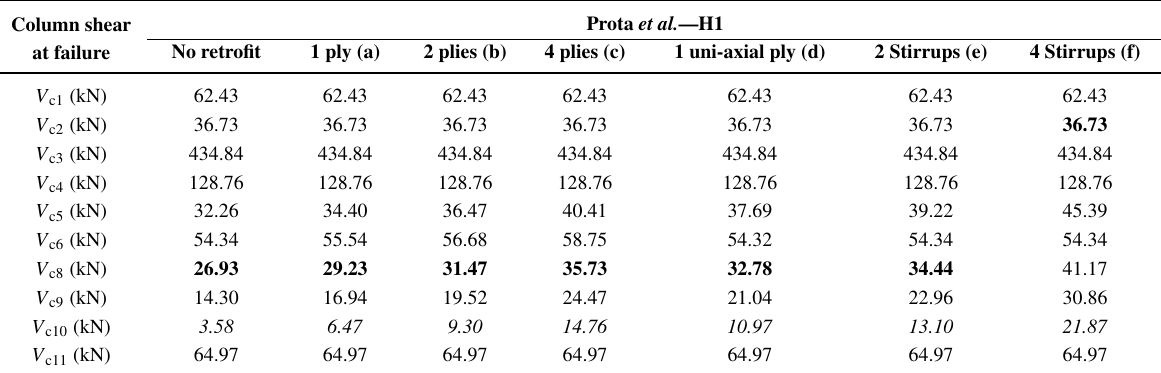
Table 9. Theoretical prediction of capacities for each potential failure modes of different retrofit solutions for specimens “H1” (Prota et al. ). Column shear